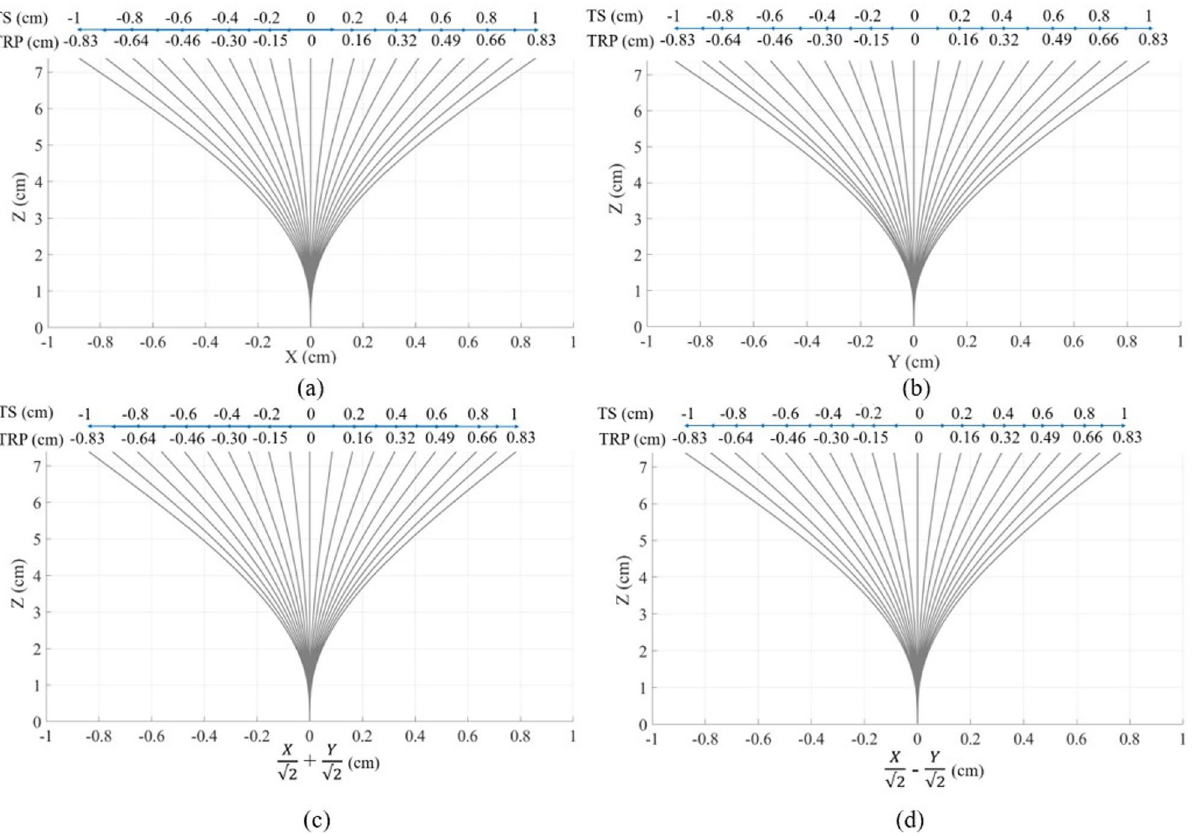
Figure 4. Needle shape reconstruction during the tip movement from 0 to 1 cm with a step of 0.1 cm for all directions: ( a ) left and right; ( b ) upper and lower; ( c ) up-right and low-left; ( d ) low-right and up-left. In this figure, TS is the tip shift relative to the needle base and TRP is the tip relative position with respect to the first sensing